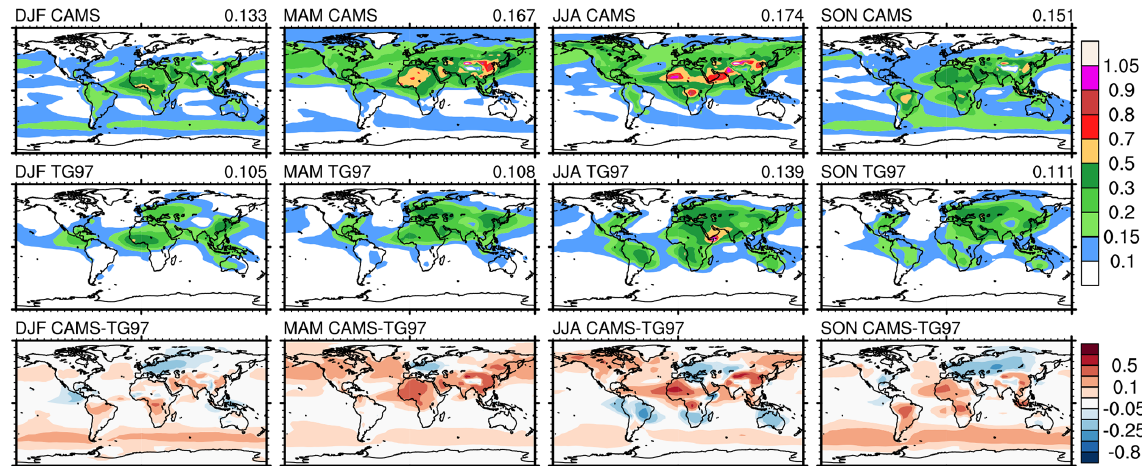
Figure 4. Seasonal total extinction aerosol optical thickness at 550nm. CAMS Interim reanalysis control run, scaled to conserve the as- similated AOT (top row) and the TG97 climatology (middle row). The bottom row shows the difference between the CAMS and the TG97 climatology.